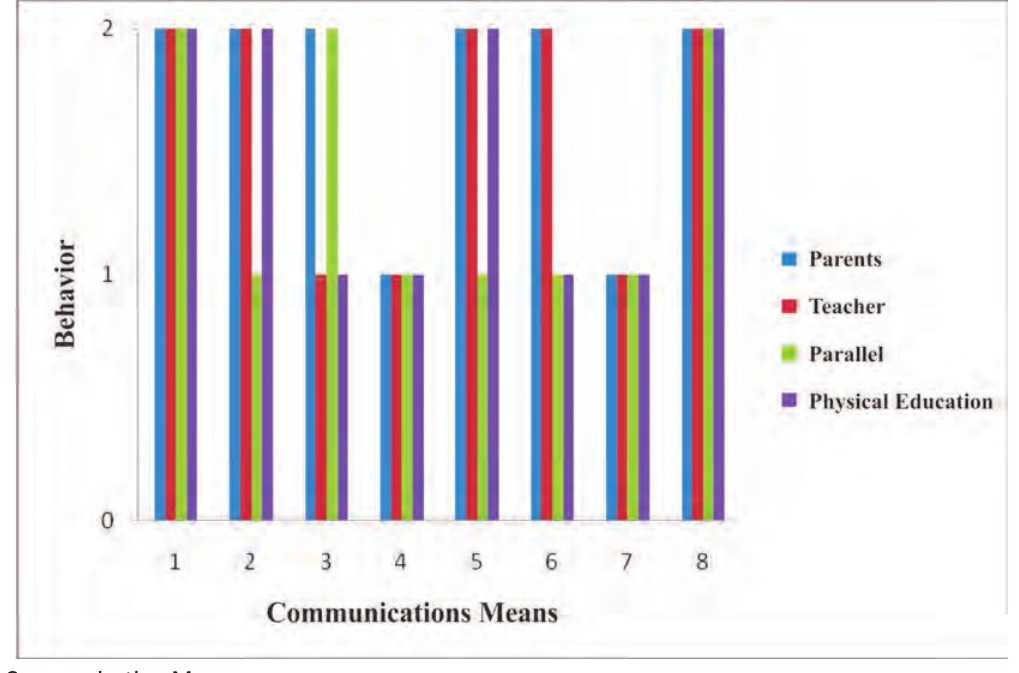
Figure 4. Communication